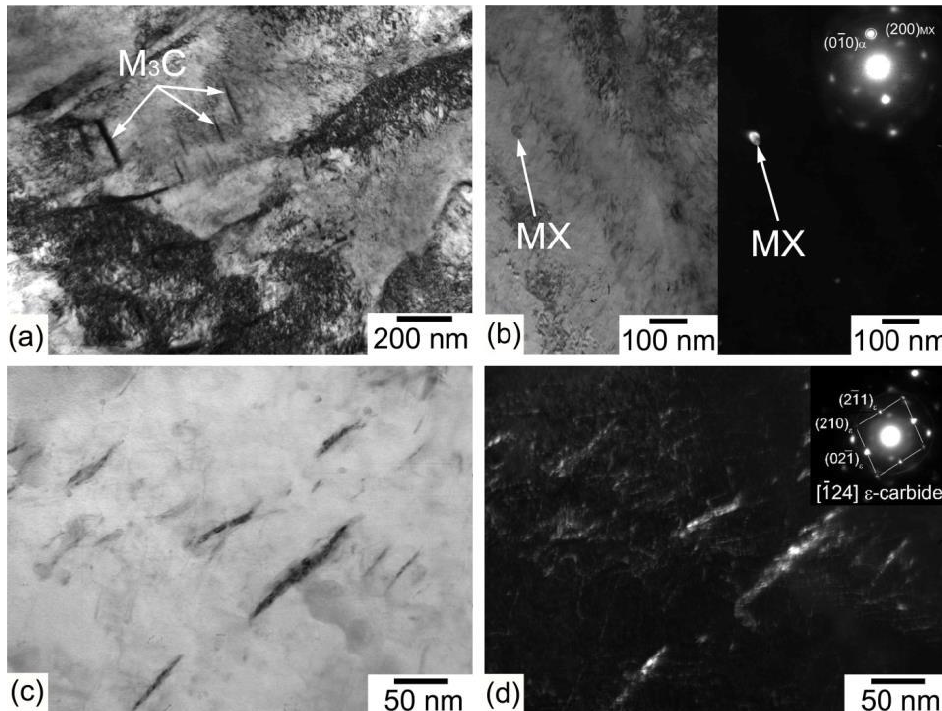
Figure 8. Typical microstructure of the steel after quenching and tempering at 400 °C: TEM micrograph of martensite lath structure with cementite particles ( a ); TEM micrograph of Nb(C,N) carbonitride within the lath (bright field on the left and dark field on the right side) ( b ); TEM micrograph of ε -carbide within the lath (bright field) ( c ); TEM micrograph of ε -carbide within the lath (dark field) ( d ).